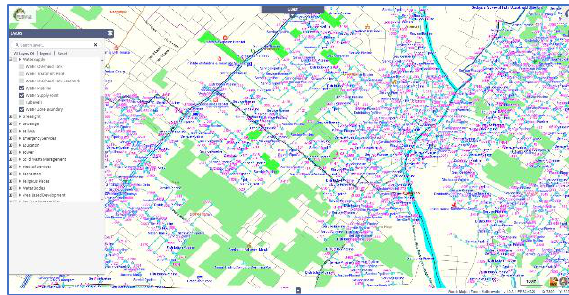
Figure_7: Water Supply Infrastructure Network layer